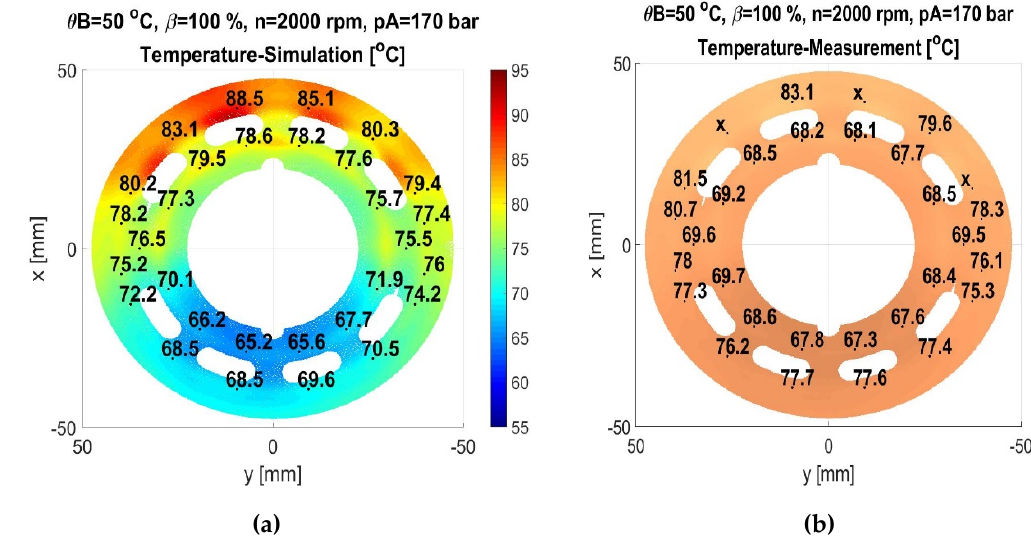
Figure 12. (a) Simulated temperature of valve plate; (b) measured temperature of valve plate.